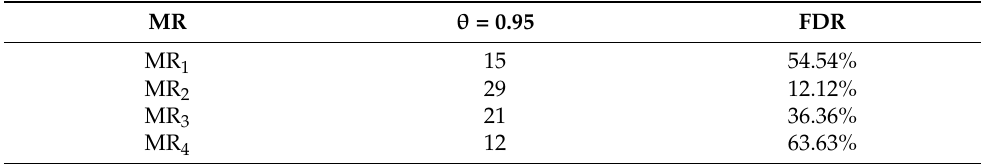
Table 5. Fault detection rate of T1-weighted images.